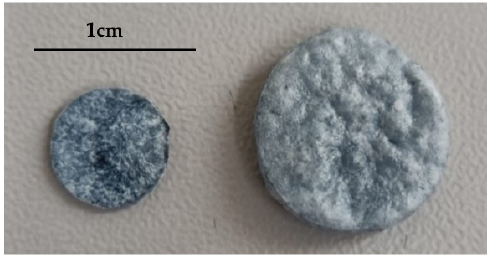
Figure 2. Photograph of a sample before ( left ) and after being subjected to the foaming process ( right ).